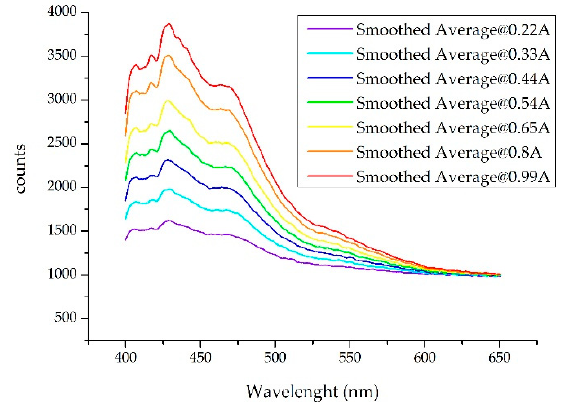
Figure 1. Spectra obtained when a Gas 95 sample is illuminated with an HP-UV LED (High Power Ultra-Violet Light Emitting Diode) at different working currents. The spectra shown were smoothed with the SG filter and had a greater range of wavelengths than that used for the job so that differences were better observed.